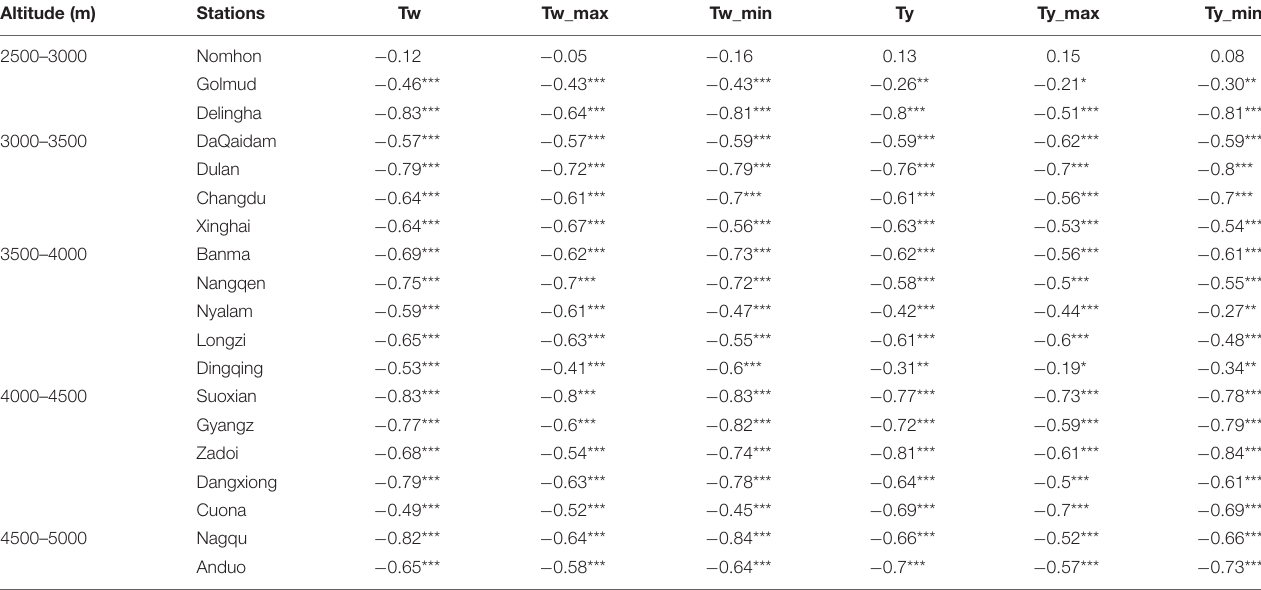
TABLE 1 | Correlation coefficient between air temperature and maximum depth of frozen soil. Altitude (m) Stations